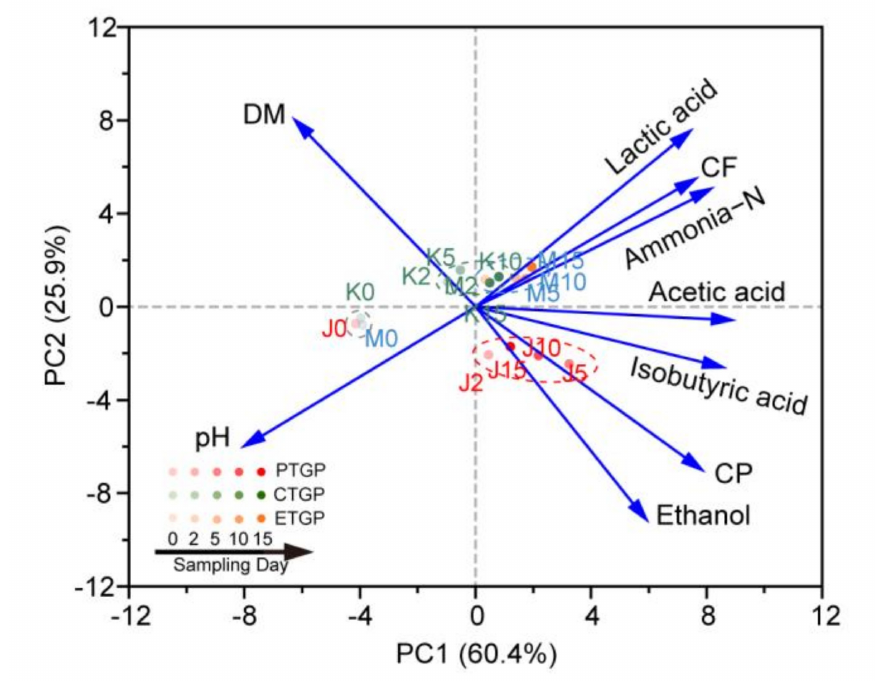
Figure 1. Principal component analysis of samples and major physicochemical indicators. DM: dry matter content; CP: crude protein content; CF: crude fat content. PTGP: the probiotics treatment group; CTGP: the control group; ETGP: the enzyme treatment group. The numbers following the J/K/M indicate the sampling time (day) of